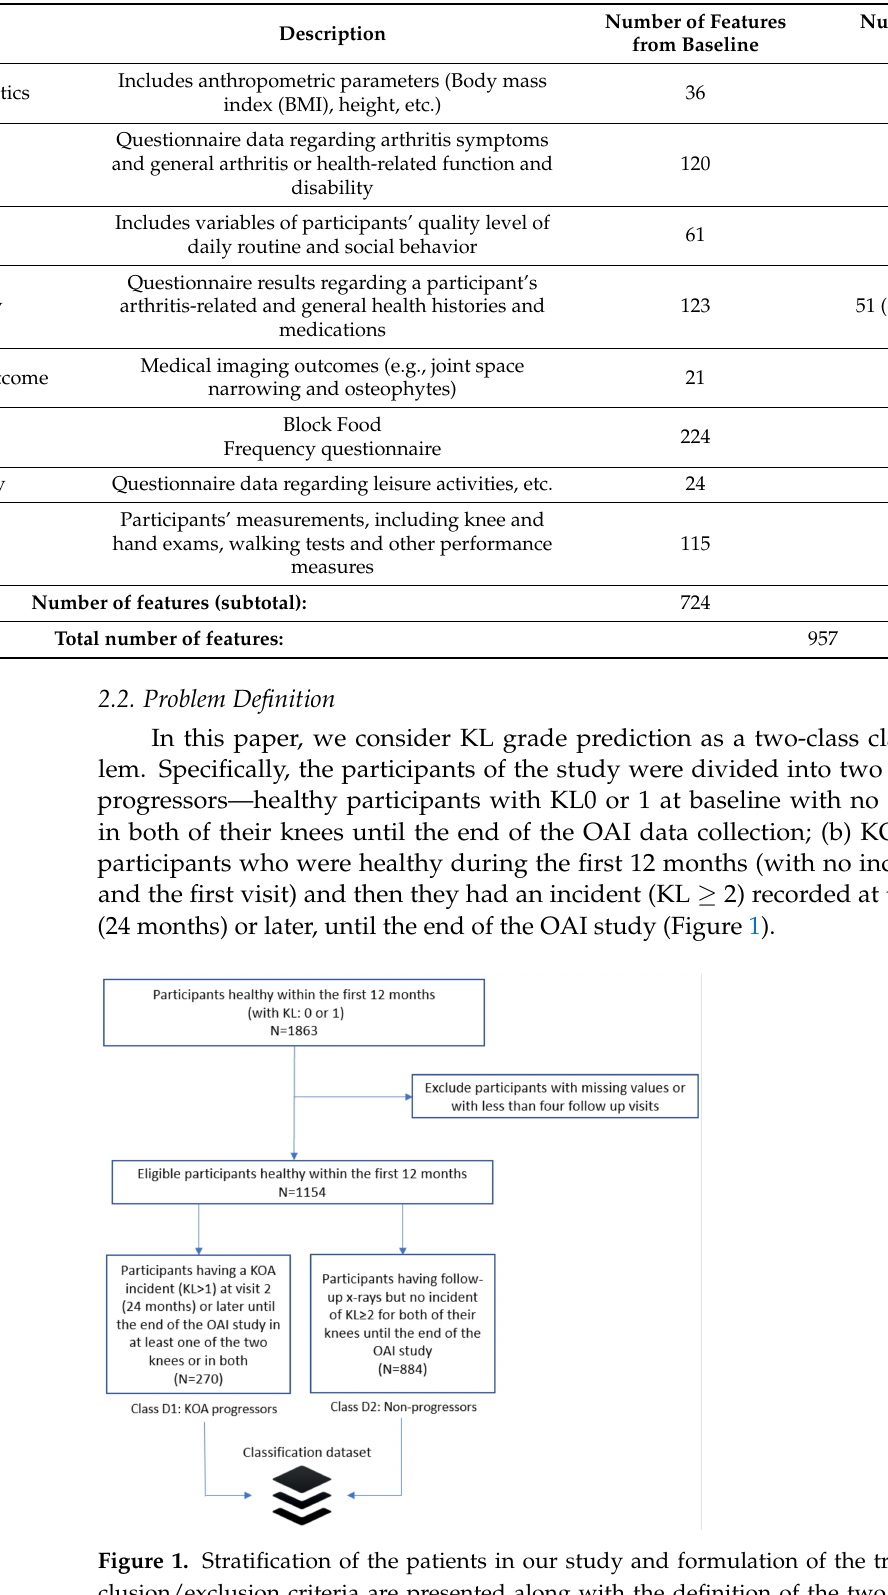
Table 1. Main categories of the feature subsets considered in this paper. A brief description is given along with the number of features considered per category and for each of the two visits.